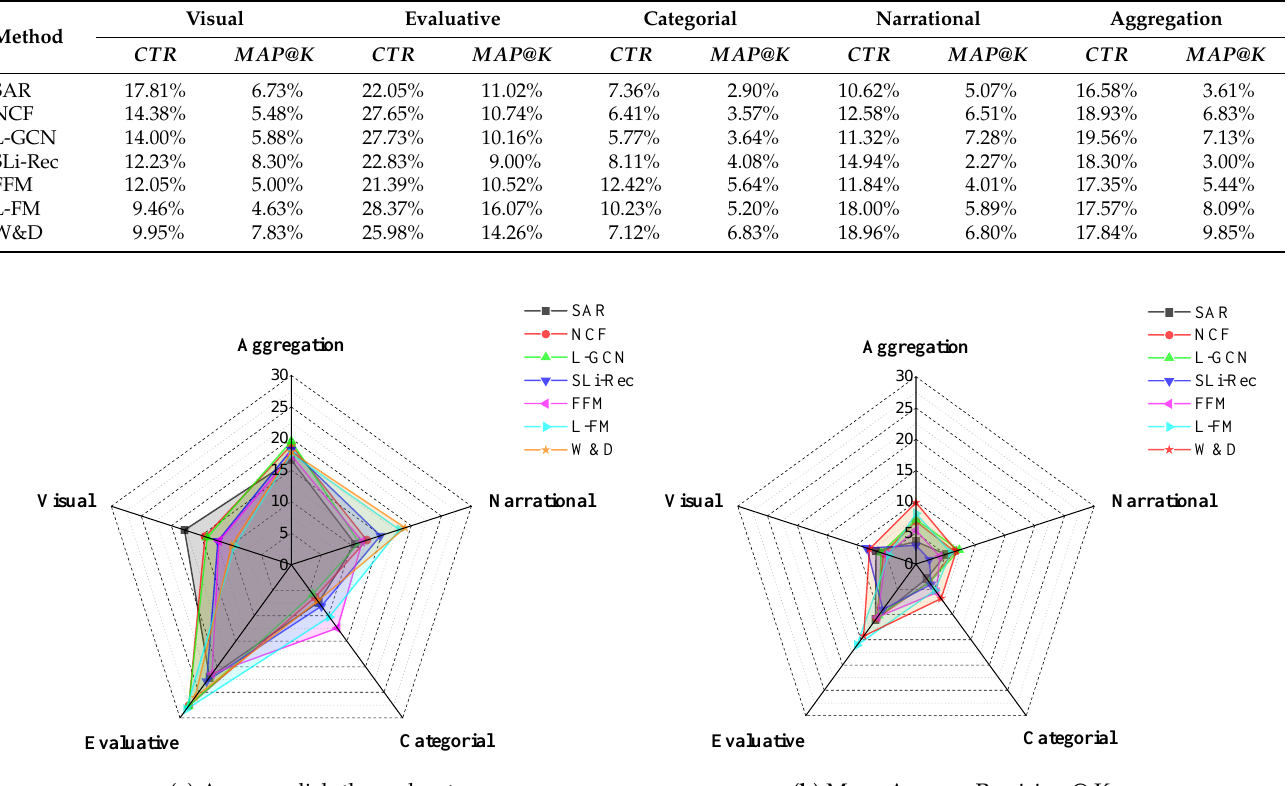
Table 7. The degree of improvement in different cases.